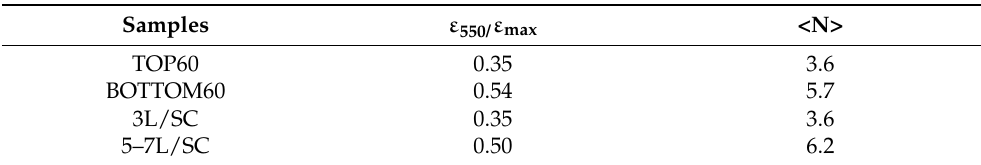
Table 2. Average layers number <N> of GNPs samples and of commercial graphene nano-sheets according to Equation (1) (see